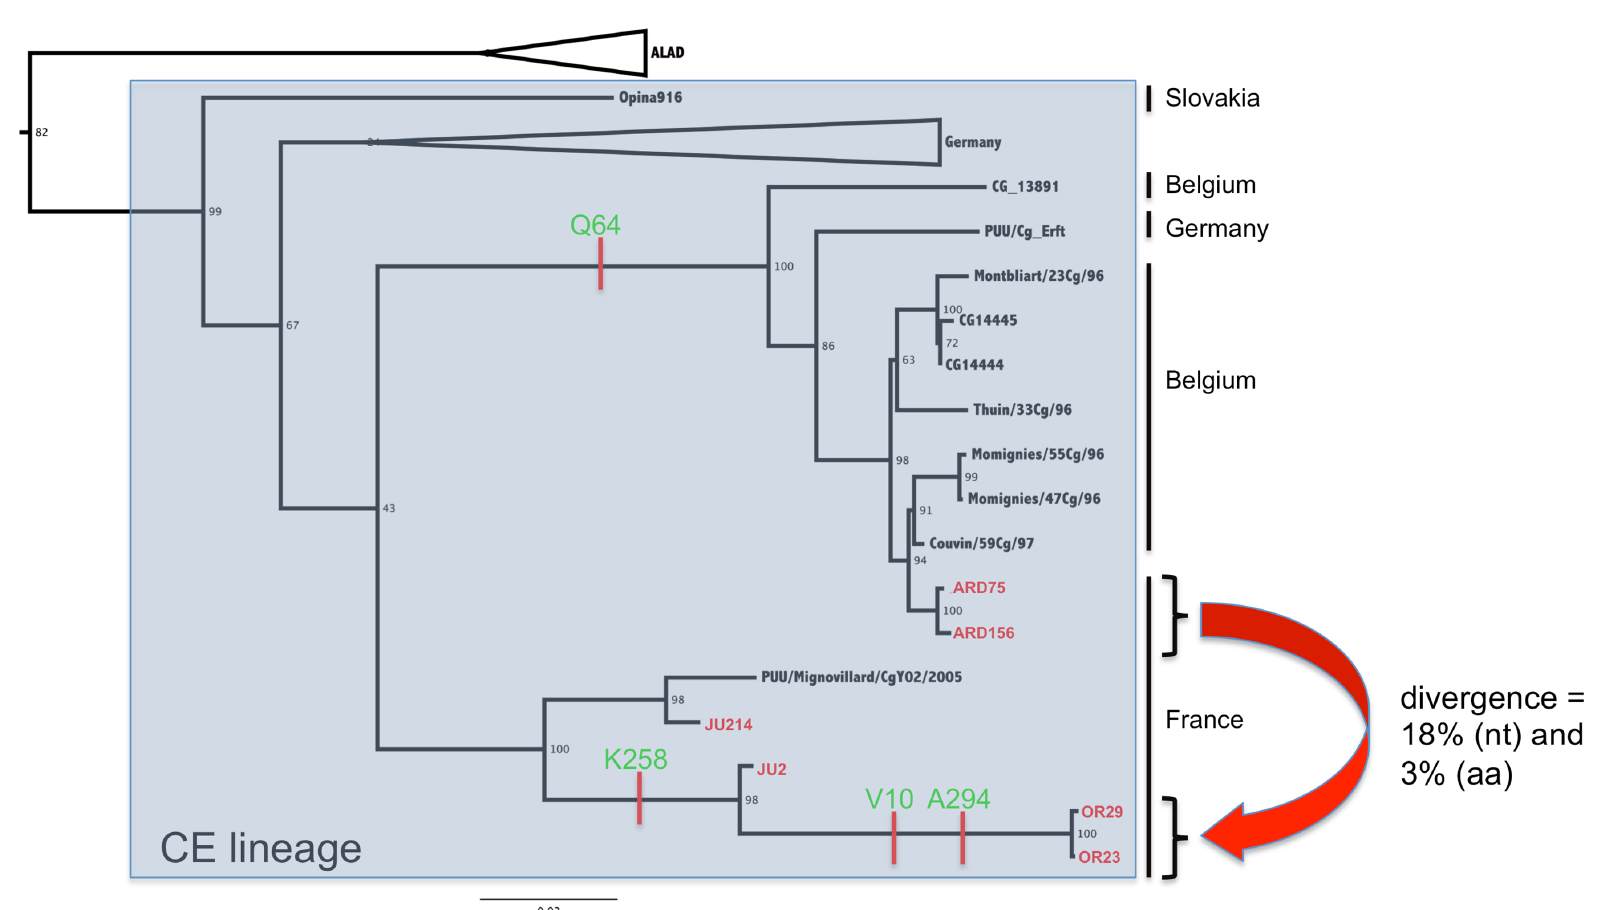
Figure 2. Phylogenetic tree based on the complete N protein coding sequences (the S segment N- ORF) of PUUV of the central European (CE) lineage. Scale bar represent the average number of substitutions per site. French isolates from this study are in red and specific amino acid (aa) signatures are indicated on the branches of the tree.